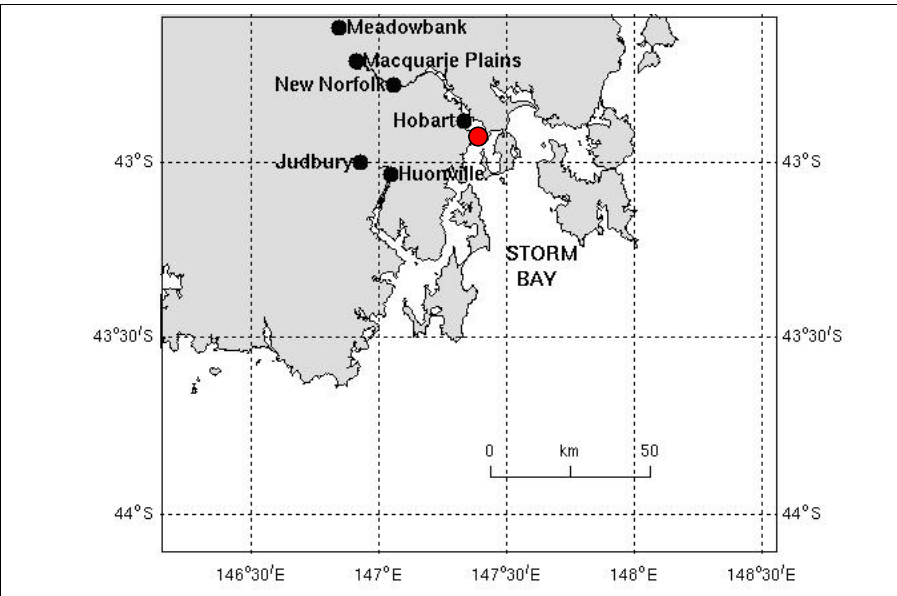
Figure 1. Query region (South East Tasmania,